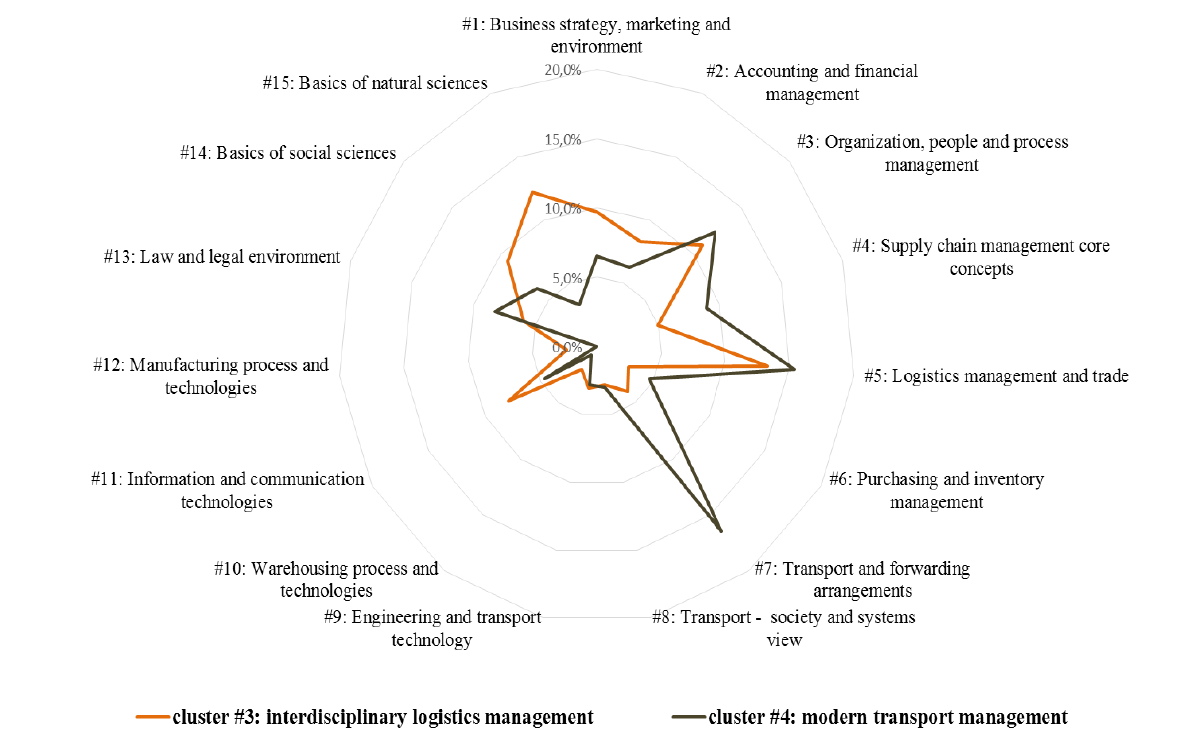
Figure 4. The contrasted curricula profiles of interdisciplinary logistics management and modern transport management Source: Authors’